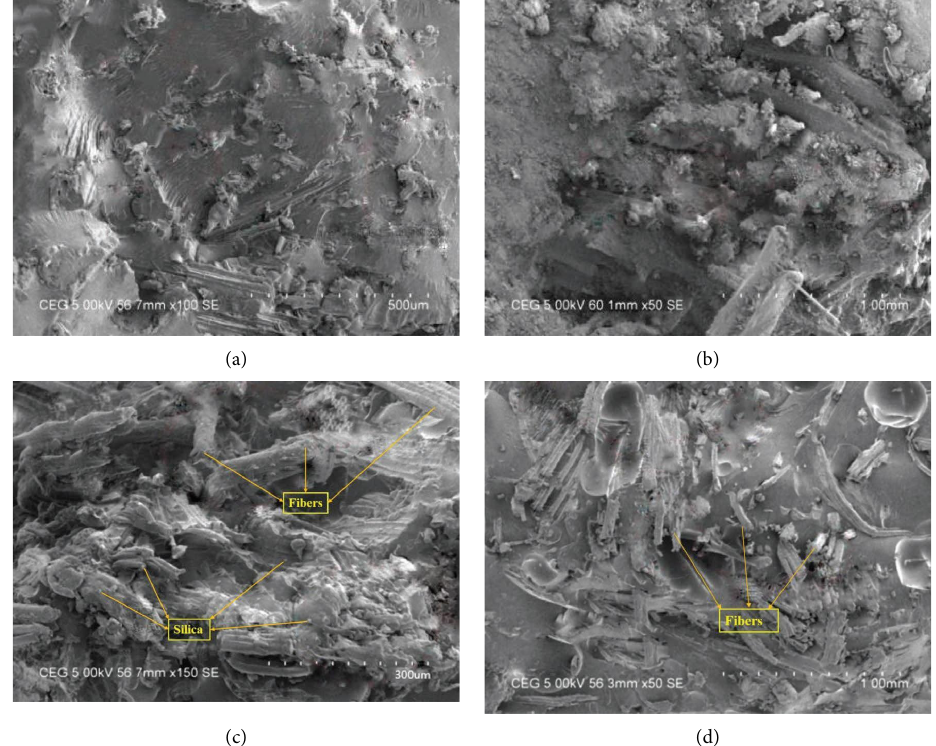
Figure 6: (a) Microstructure of the composite samples for fbre 15 wt.% with 5 mm length. (b) Microstructure of the composite samples for fbre 15 wt.% with 10 mm length. (c) Microstructure of the composite samples for fbre 15 wt.% with 15 mm length. (d) Microstructure of the composite samples for fbre 15 wt.% with 20 mm